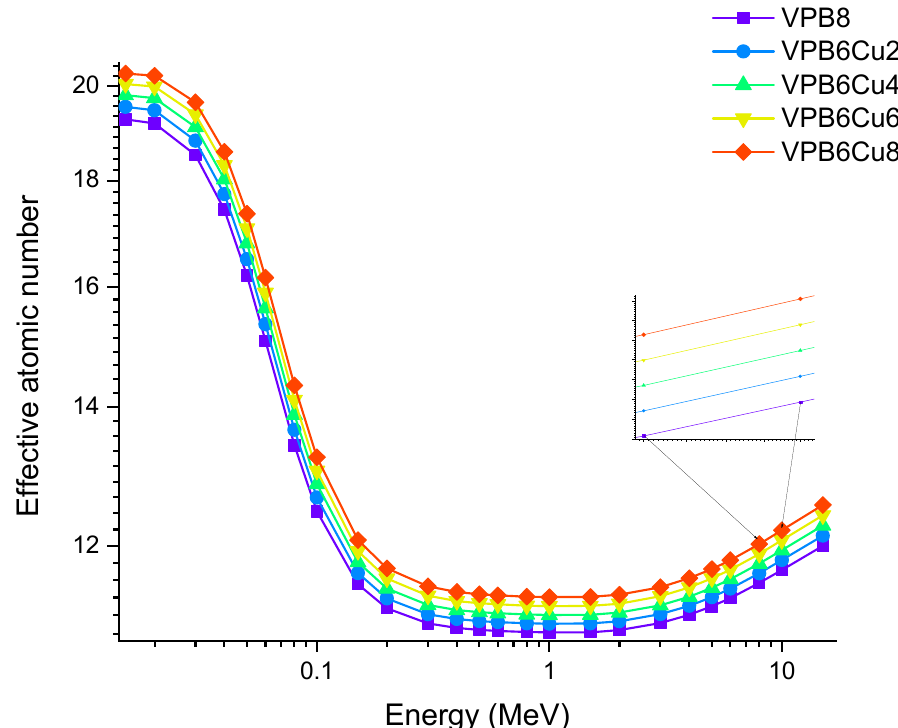
Figure 10. Variation of effective atomic number (Z eff ) against photon energy for VPB x Cu y glass samples. Accordingly, the glass sample with 0% CuO (VPB8) has the lowest Z eff values. The EABF and EBF are significant photon shielding characteristics that are used to define scattering in irradiated materials. The variance in EBF and EABF values for all glass material was analyzed using the geometric progression (G-P) fitting technique for the energy range 0.015 MeV to 15 MeV and penetration depth range of 0.5 to 40, mfp, as shown in Figures 11a,b, 12a,b, 13a,b, 14a,b and 15a,b. It increases with decreasing incoming photon energies until it reaches a maximum in the intermediate energy range, at which point it begins to decline again. The majority of the gamma ray absorption occurs at lower energies, where the photoelectric effect is prominent, and at higher energies, when photoelectric interactions are predominant, according to the literature. The accumulation of photon energy is restricted in these energy zones. For its part, Compton scattering is the most often observed process at intermediate energies because it includes photon absorption rather than absolute photon loss. As a consequence, the EBF values in the Compton area are at their highest levels ever recorded in the region. In this study, EBF values were observed sample increases, the EBF values decrease. For example, at 0.1 MeV and 40 mfp the EBF values for were 43.622 and 30.634 for samples VBP8 and VPCu8, respectively. The EABF component is a quantity influenced by the amount of energy in the substance as well as the detector characteristic in the interacting material. A variation trend similar to that seen in EBF is observed for EABF. Likewise, the lowest values are reported for the sample with the highest CuO content,